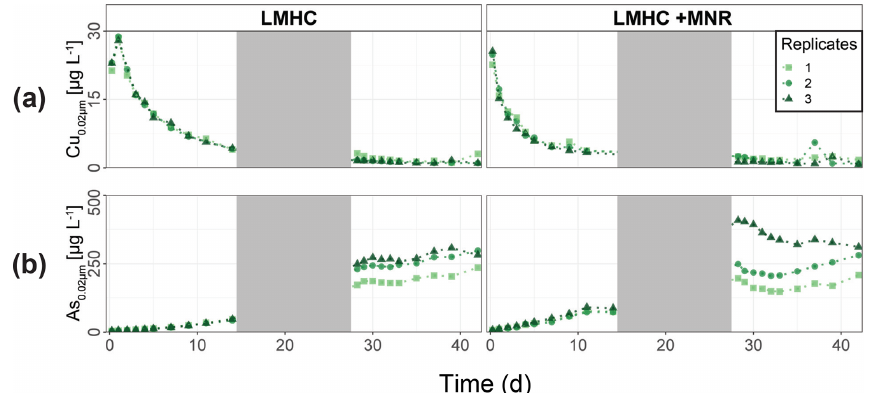
Figure 7. Soil solution dynamics in pasture field soil (LMHC) incubations for Cu (a) and As (b) . Lines between points were plotted to improve readability. The gray area indicates the drained